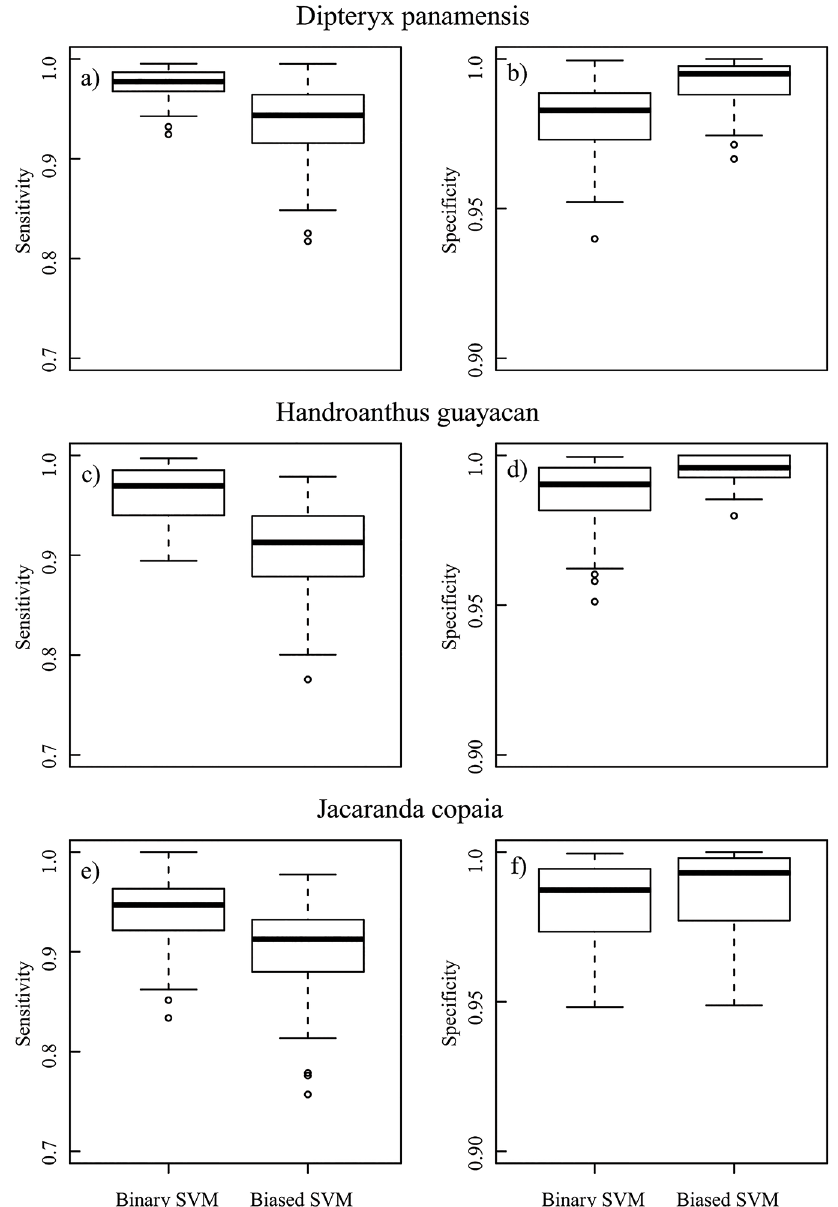
Fig 3. Performance of binary and biased SVM for the three focal species. Results are given for both model sensitivity (a, c, e) and specificity (b, d, f) measured on the spectra from a separate set of crowns. Sensitivity is the proportion of focal class samples that are correctly assigned to the focal class and specificity is the proportion of outlier class samples that are correctly assigned to the outlier class. Note the difference in the y-axis between sensitivity and